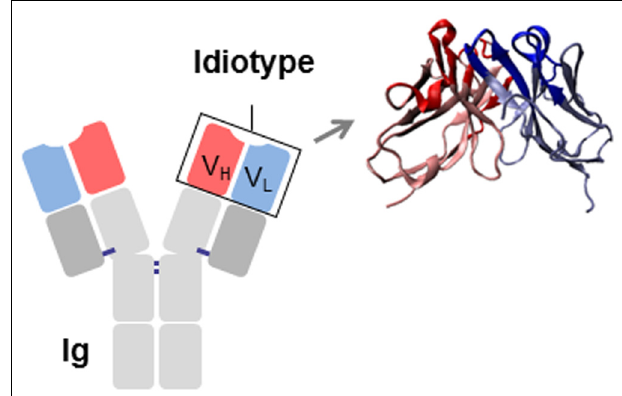
FIGURE 1 | Schematic representation of an immunoglobulin (Ig). The idiotype (Id), constituted by the variable regions of the heavy (V H ) and light (V L ) chains, is shown. CDRs are highlighted in red (V H ) and blue (V L